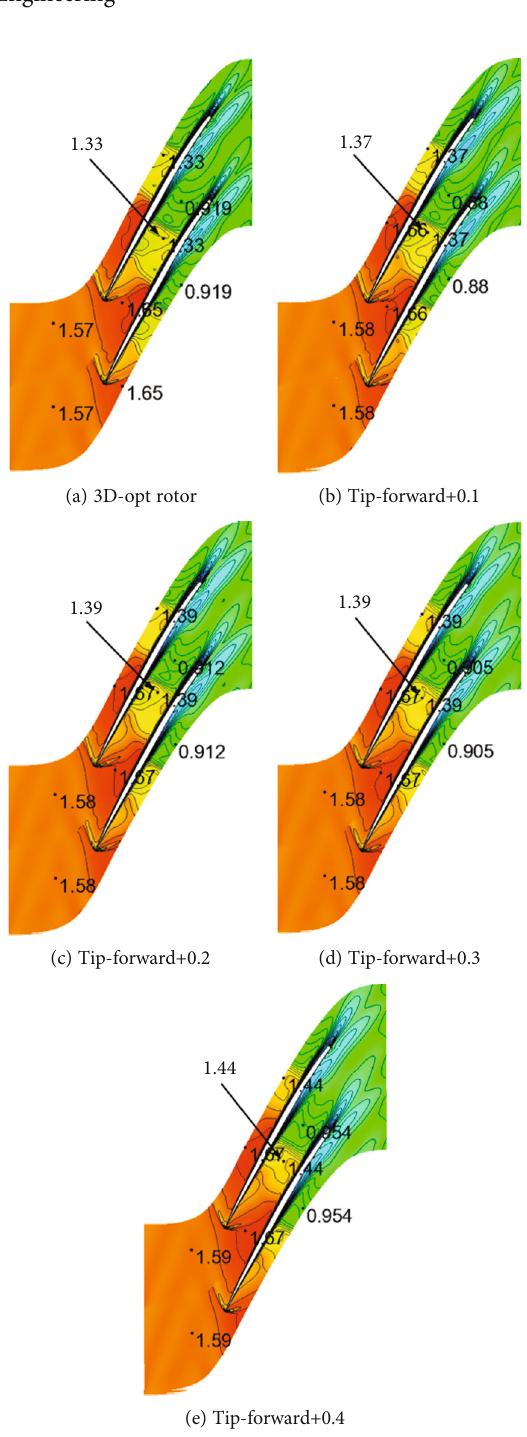
Figure 23: Mach number contours at 90% span of the fi ve rotors at the design